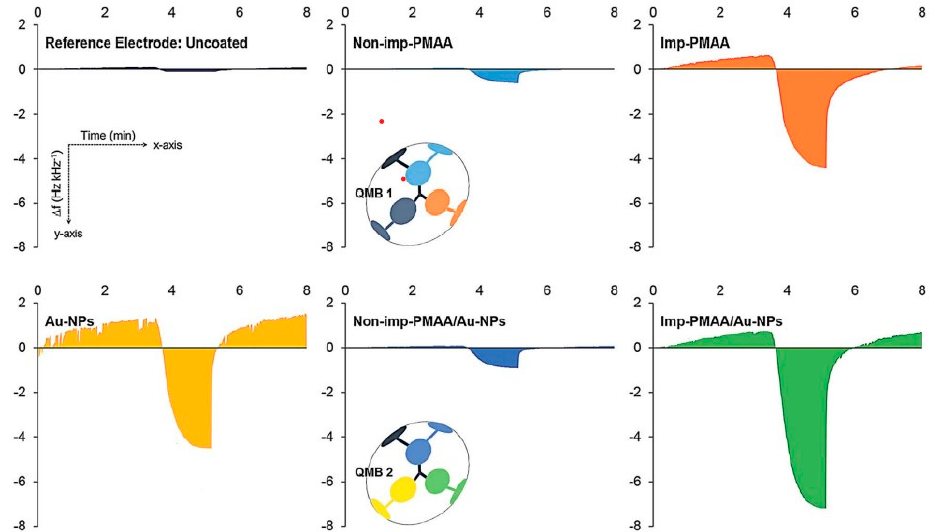
Figure 3. Control experiments: time-dependent frequency response of 2 tri—electrode QMB devices coated with different sensing materials toward 1 ppm formaldehyde gas at 25 °C and 50% RH. These sensor responses are normalized to 1 kHz or 40 nm of layer thickness [86]. (Copyright (2014) Royal Society of Chemistry).